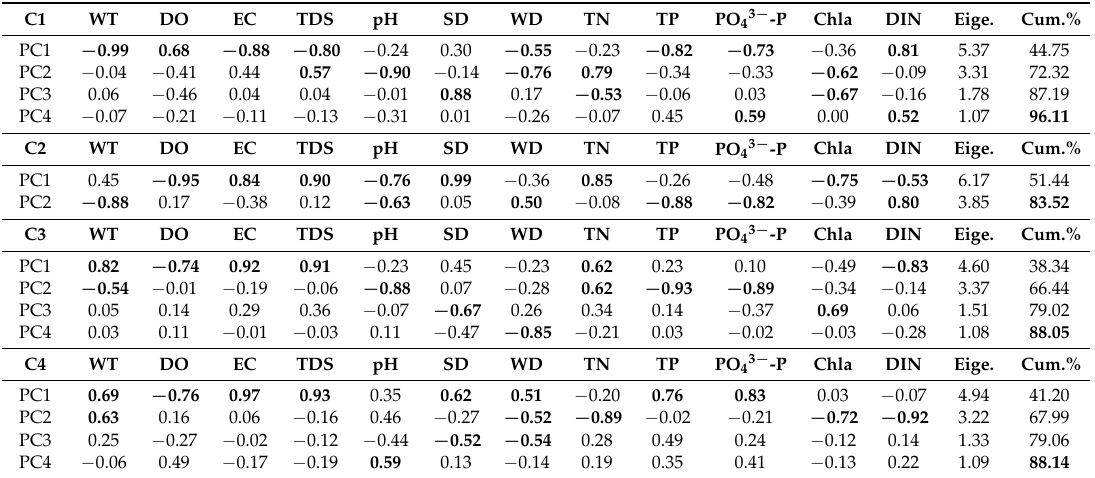
Table 5. Component loadings of each parameters and cumulative variance of the principal components.